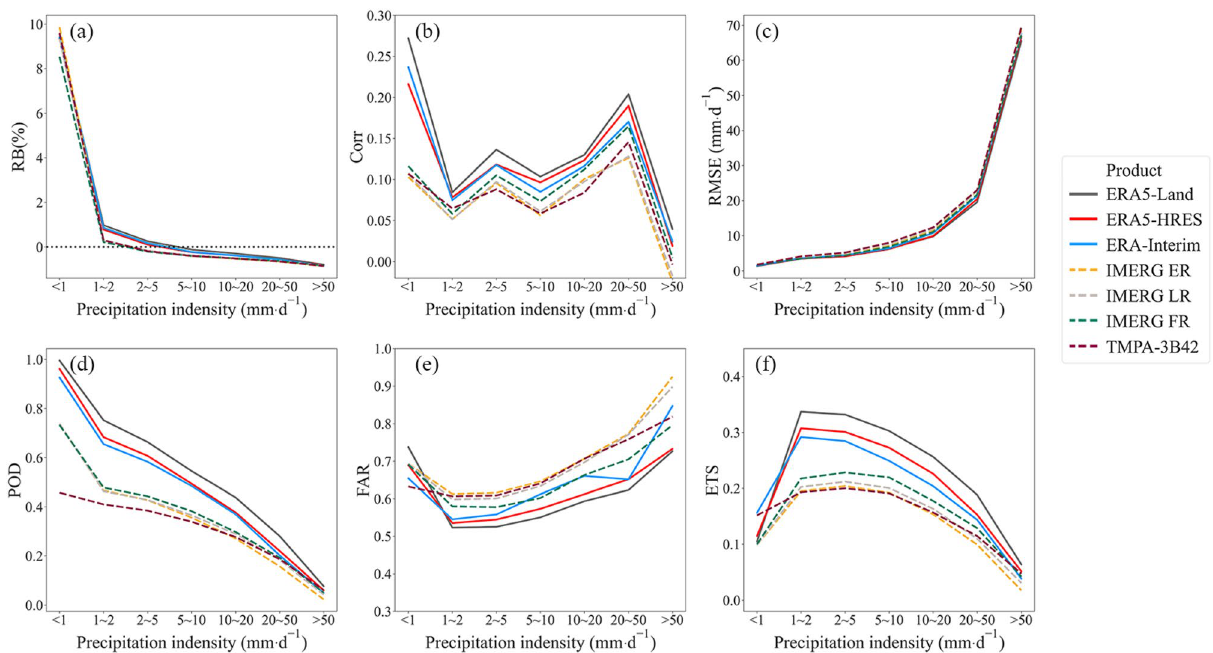
Figure 7. Changes in ( a ) RB , ( b ) Corr , ( c ) RMSE , ( d ) POD , ( e ) FAR , and ( f ) ETS across different precipitation intensity